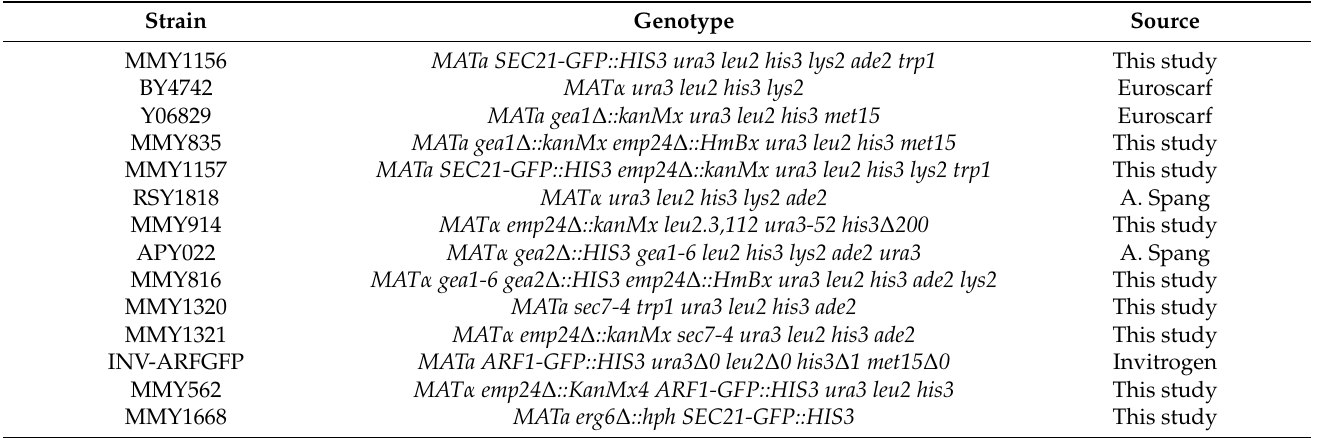
Table 1. Saccharomyces cerevisiae